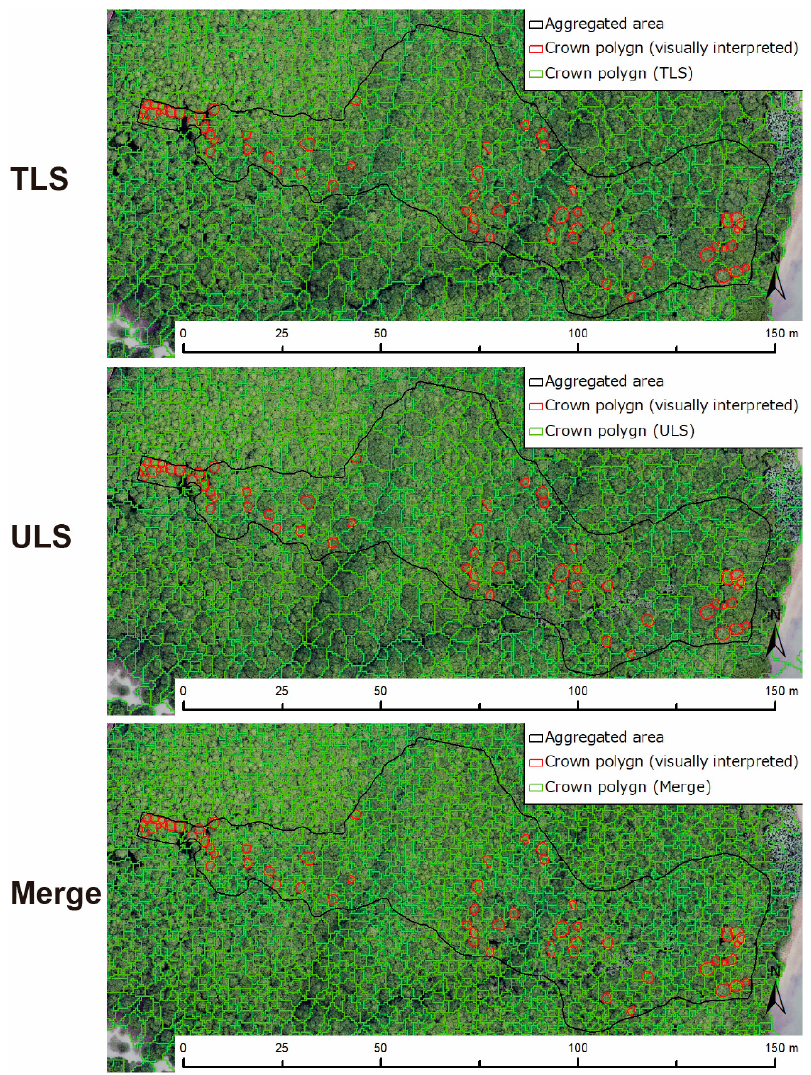
Figure 8. Tree canopies identified through tree